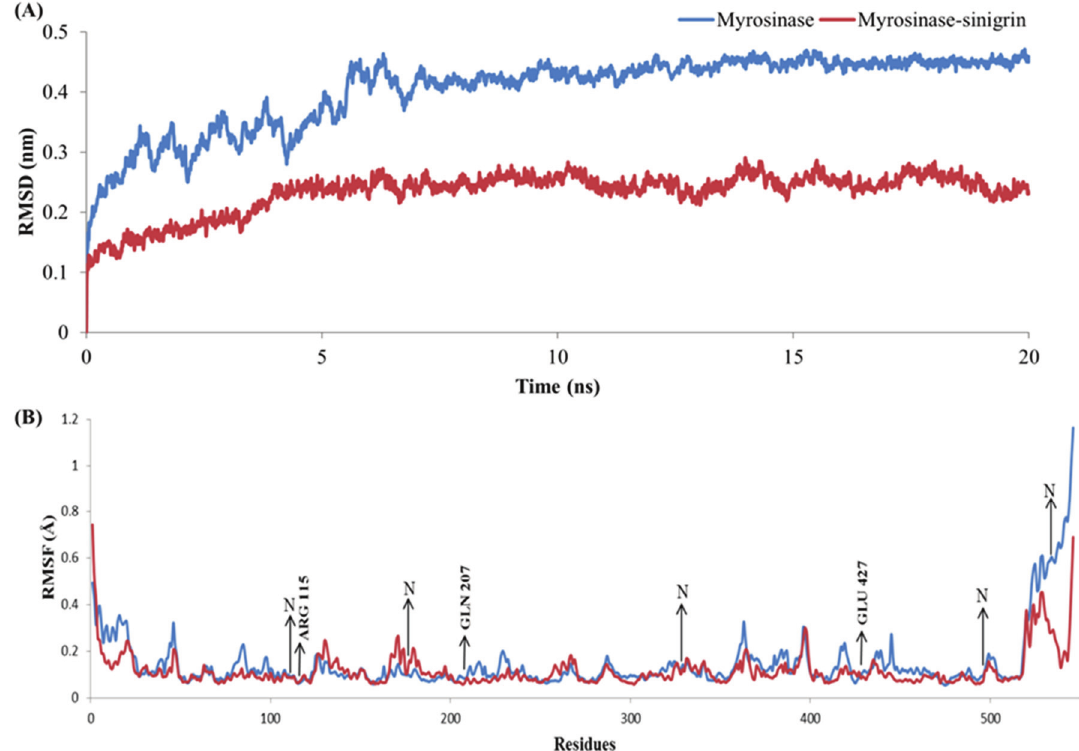
Figure 6. The root mean square deviation (RMSD) values of backbone ( A ) and root mean square Flucyuations (RMSF) values of atoms ( B ) for myrosinase and myrosinase-sinigrin complex during 20 ns dynamic